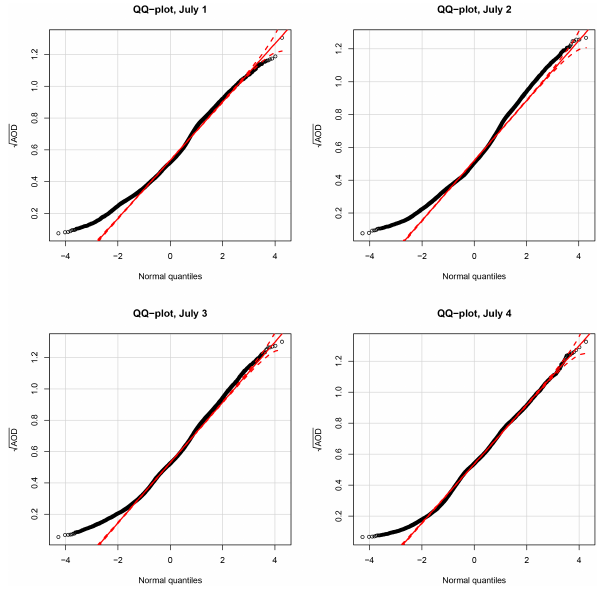
Figure A1. Normal Q–Q plots of the log-transformed PM 2 . 5 on 4 consecutive days.